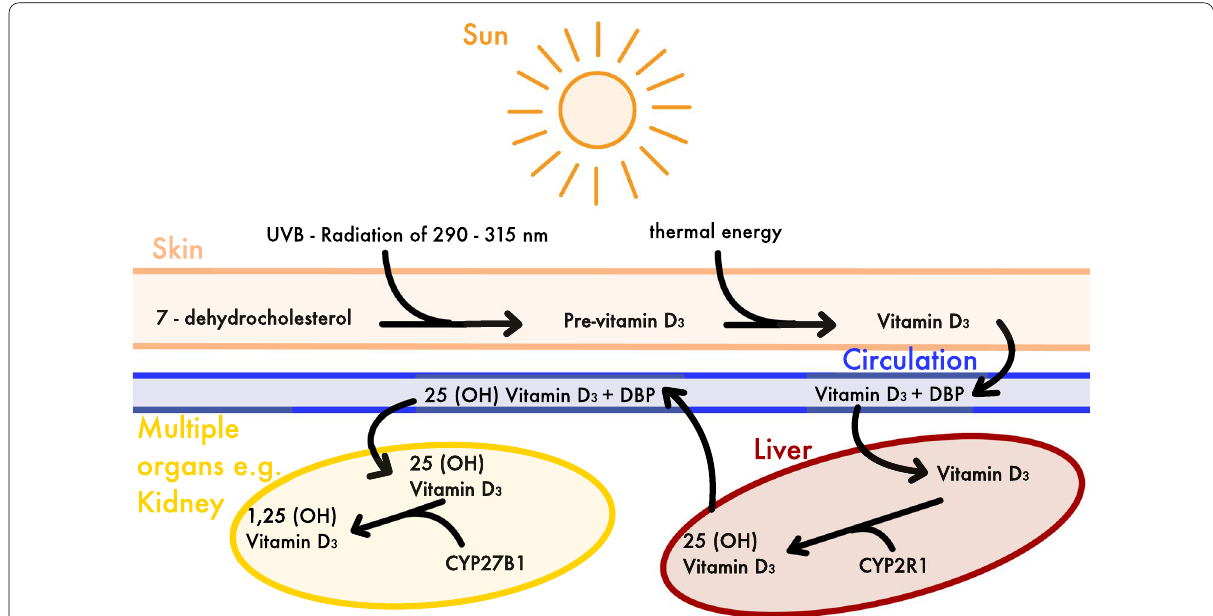
Fig. 1 Endogenous synthesis of 1,25 (OH) Vitamin D. DBP: Vitamin D‑binding Protein, CYP2R1: Vitamin D 25‑hydroxylase, CYP27B1: 1